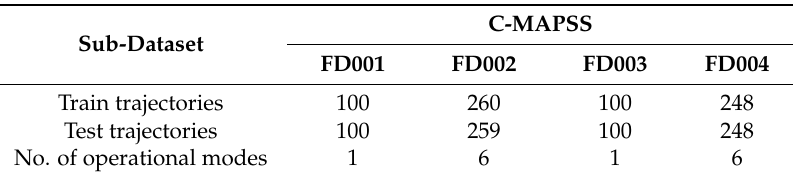
Table 2. NASA C-MAPSS dataset